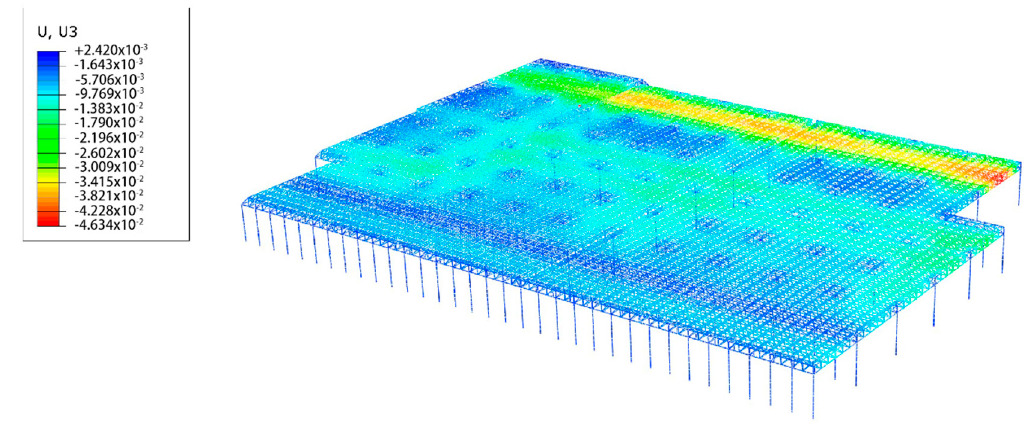
Figure 11. Vertical displacement of the steel-reinforced concrete column system.